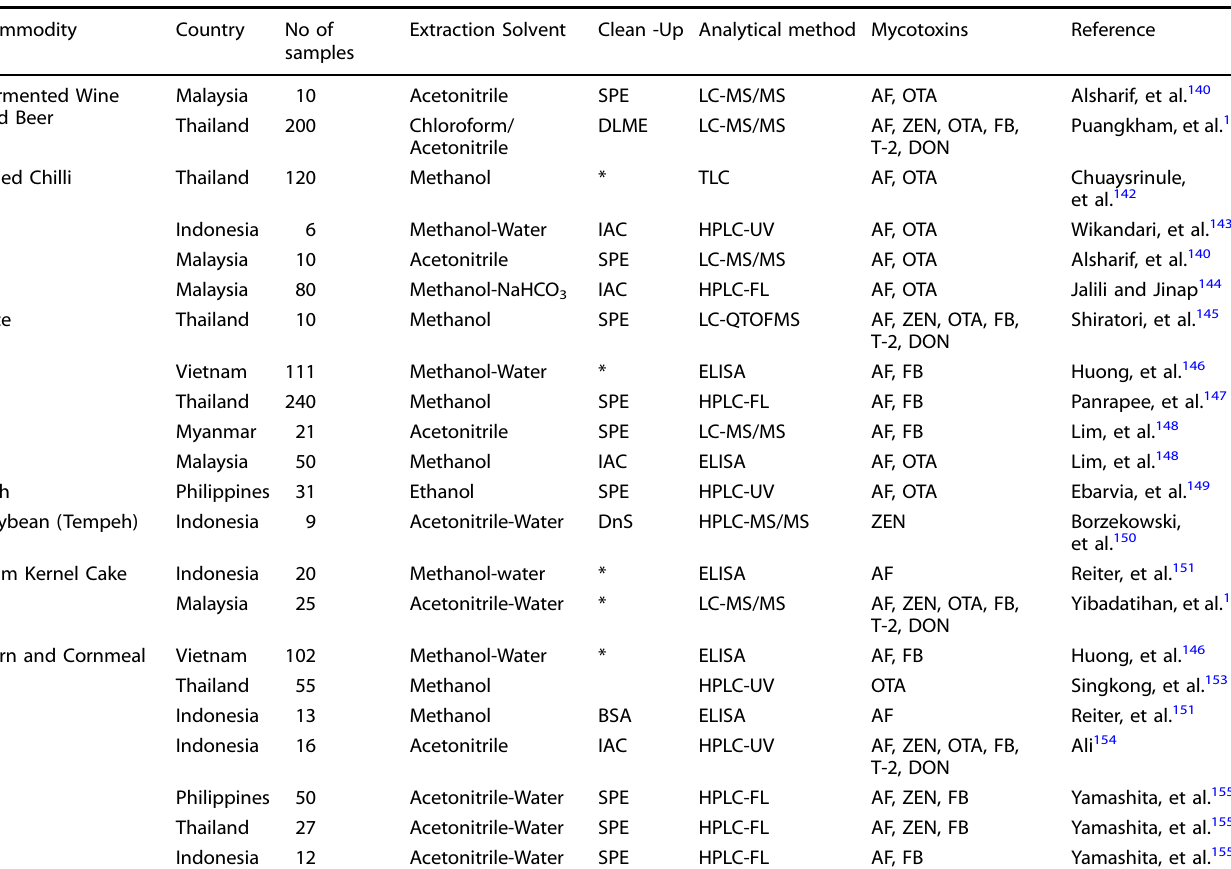
Table 2. Sample preparation and analytical techniques for the determination of mycotoxins in SEA fermented foods and raw materials used for preparing fermented foods.